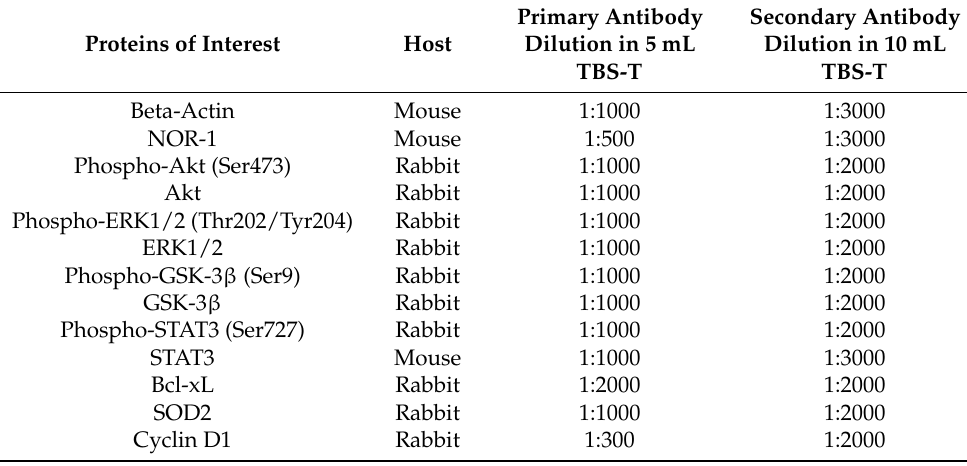
Table 2. Dilutions used for the different primary and secondary antibodies.